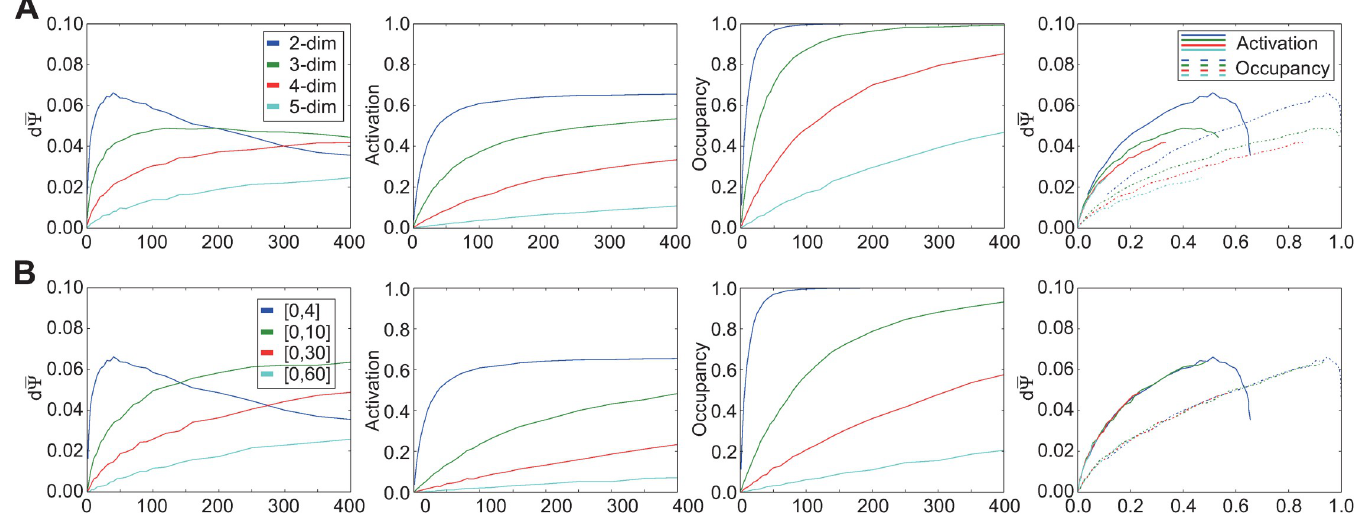
Fig 7. Effects of increasing Q-space dimensionality compared with increasing the size of a two-dimensional Q-space. Receptor activation and receptor occupancy curves are separately depicted ( center panels ). A. Effects of increasing Q-space dimensionality. Each dimension spanned a range of four q-units, such that the three- dimensional Q-space had a range of [4,4,4],the four-dimensional Q-space was [4,4,4,4],etcetera. B. Effects of increasing the range of a two-dimensional Q-space. Most of the observed effects of higher dimensionality resembled the effects of simple increases in the size of the space, with subtle differences in curvature (compare leftmost three panels ). However, Q-space dimensionality, but not range, affected the relationship between activation or occupancy and the discrimination capacity. Most significantly, increased dimensionality clearly reduced peak discrimination capacity, all else being equal, rather than simply moving the curve to the right so as to track receptor activation. This suggests that the larger number of factors contributing to net receptor activation changes based on any single ligand point’s transition dN tends to strengthen a regression to the mean effect, thereby reducing the likelihood of substantial changes in net receptor activation on which discrimination capacity depends.